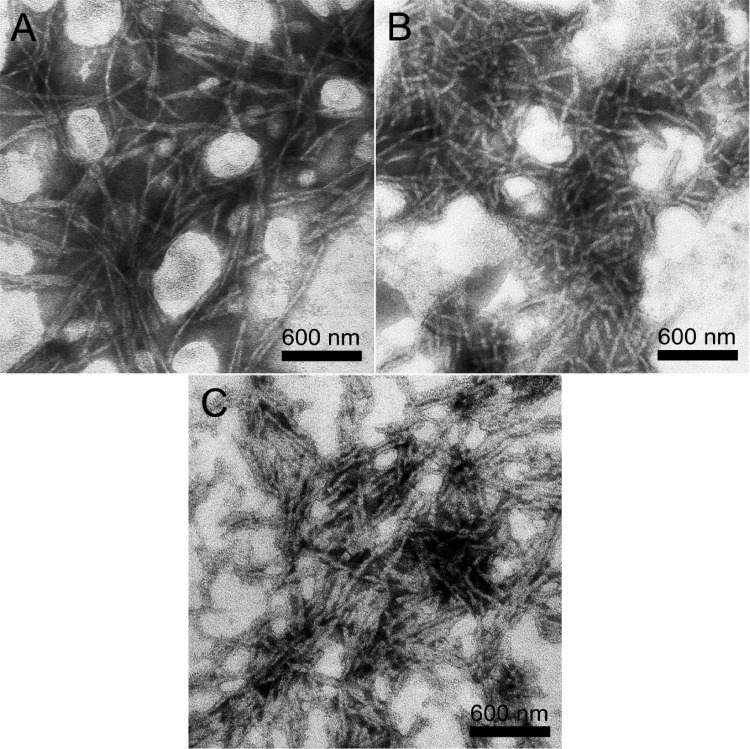
TEM images of the nanostructures formed from (A) RADA-RGD, (B) RADA-TTS and (C) RADA-FOG in phosphate buffer. All of the peptides were diluted with 50 mM PBS (pH 7.2) to 0.05% wt/vol and negatively stained with phosphotungstic acid before observation.